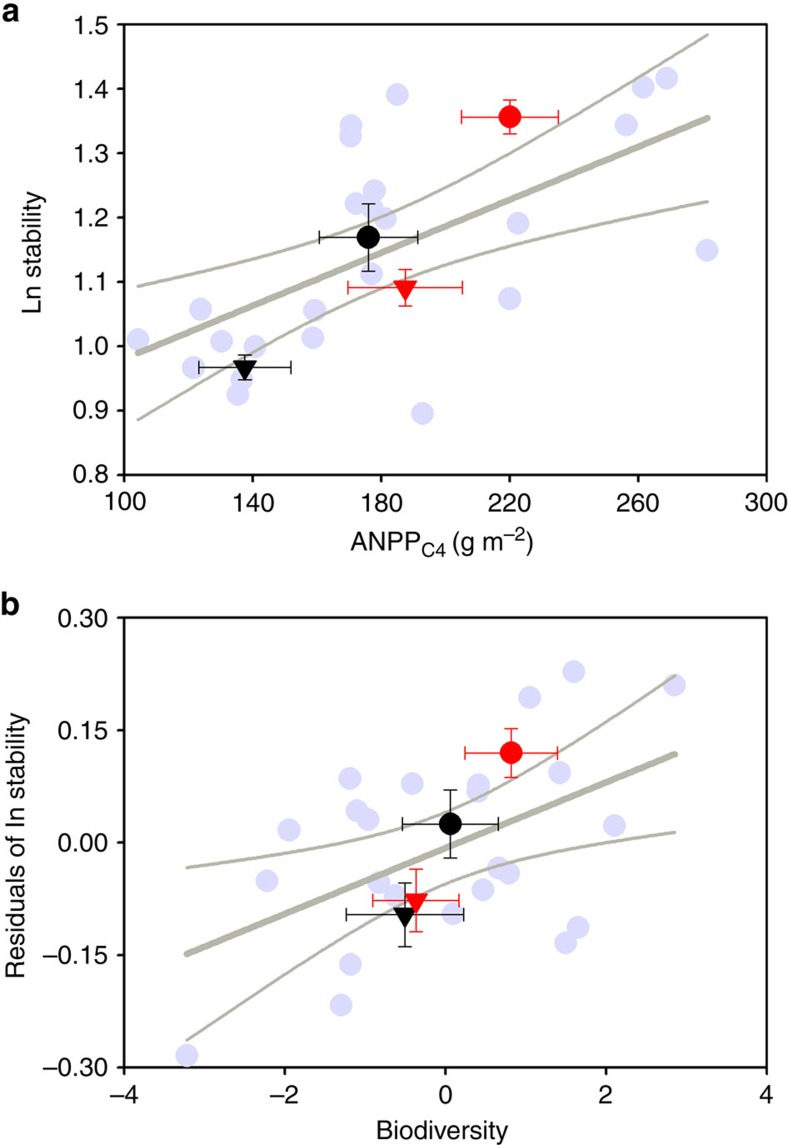
Relationships between plant community and the temporal stability of ANPP.The relationship between mean annual C4 ANPP (a) and biodiversity (b), and the temporal stability of ANPP within 2000–2014. The temporal stability is positively dependent on mean annual C4 ANPP (F1, 22=13.7, P=0.001) and the residuals of the stability after controlling for C4 ANPP effect is positively associated with biodiversity (F1, 22=7.83, P=0.01). Both factors together explained 56% variations in the temporal stability. Grey circles represent values in each of the experimental plots. The black symbols are the mean values with s.e.'s across replicates (n=6) for plots under ambient temperature and the red symbols are the mean values with s.e.'s across replicates (n=6) from warmed plots; the triangles are the mean values with s.e.'s across replicates (n=6) from clipped plots and the black and red circles are the mean values with s.e.'s across replicates (n=6) from unclipped plots. Grey line shows linear fit with 95% confidence interval. Here the biodiversity was the first component of a principal component analysis with richness, evenness and diversity (Supplementary Fig. 4).